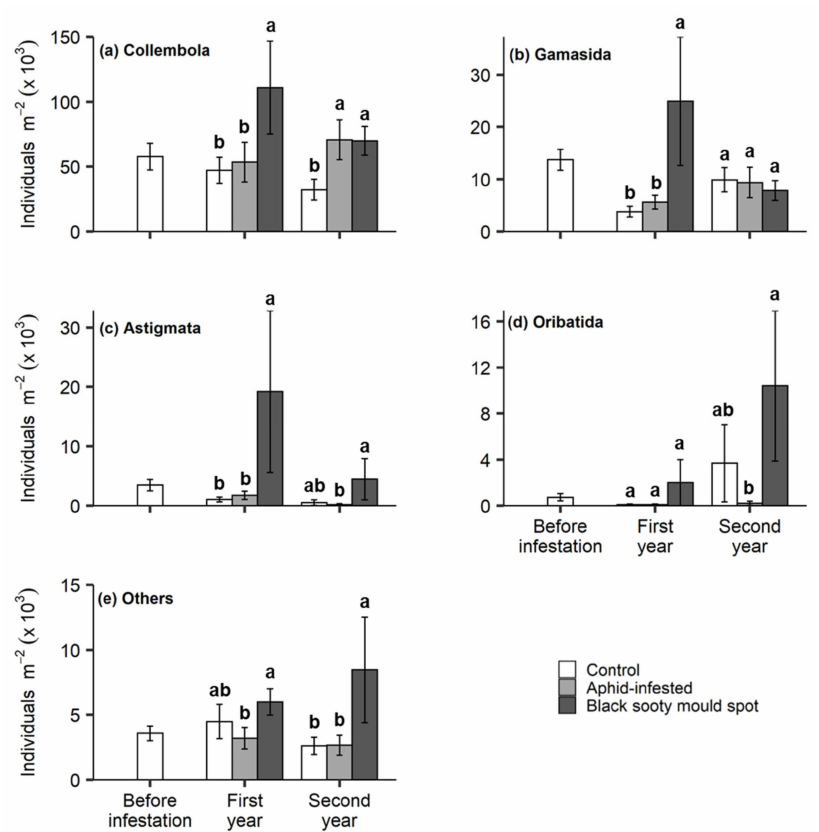
Figure 2. The e ff ect of T. salignus honeydew deposition on the abundance of soil meso-fauna: Collembola ( a ), Gamasida ( b ), Astigmata ( c ), Oribatida ( d ) and others ( e ), prior to aphid inoculation (before infestation), and after aphid inoculation (control, aphid-infested, and black sooty mould spots) in the first and second year. The values are the means ± SE. Di ff erent letters indicate statistically significant di ff erences between treatments within each sampling time (Tukey’s HSD test, α =